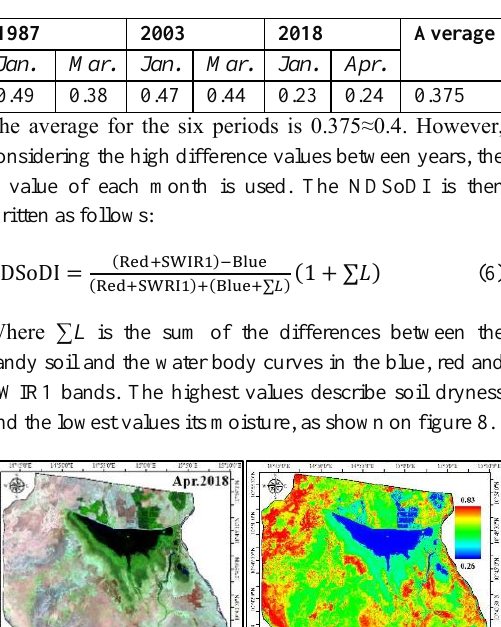
Table 2. Adjustment factor’s values ( L )